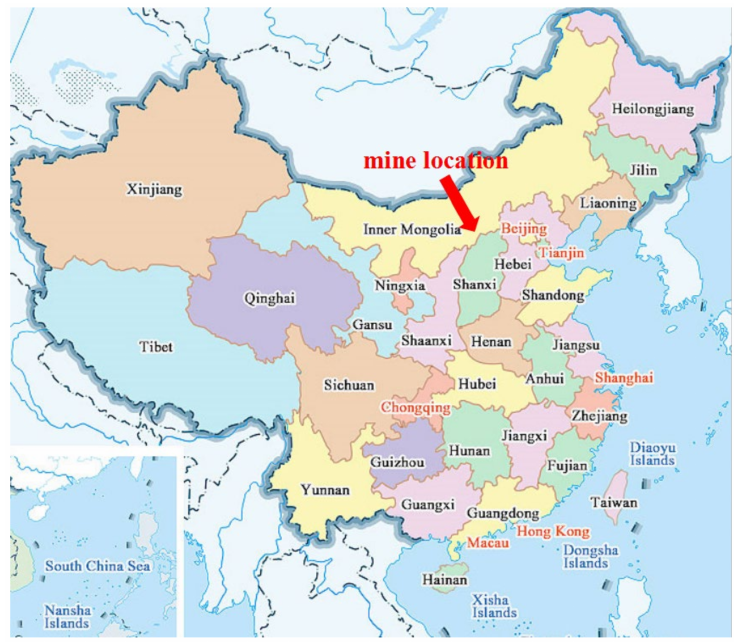
Figure 3. Location of mining